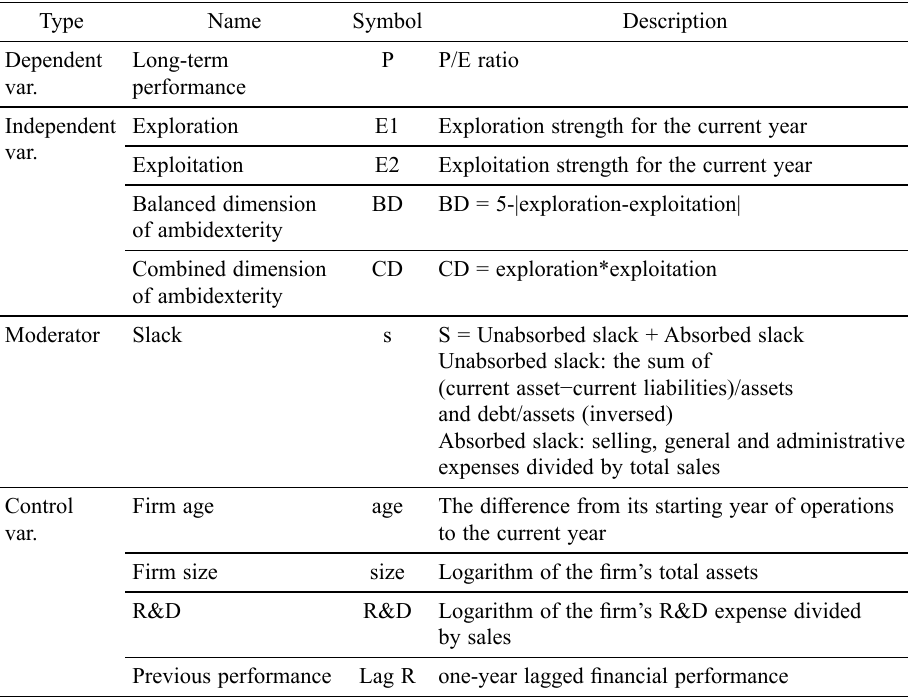
Table 2. Definition of